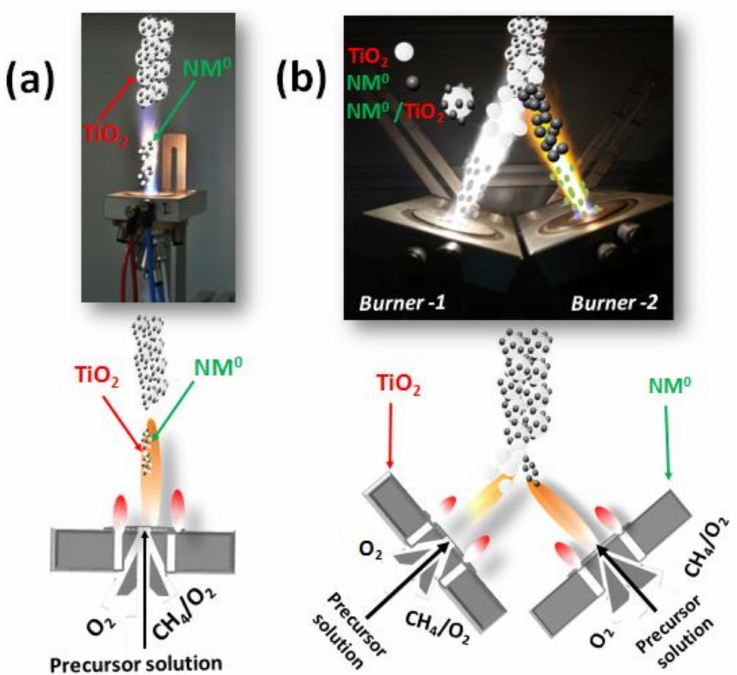
Figure 1. Our Flame Spray Pyrolysis (FSP) set-up: ( a ) One Nozzle-FSP. TiO 2 and NM 0 = Pt 0 , Pd 0 , Au 0 , Ag 0 , are formed in the same nozzle; ( b ) Double-Nozzle. Burner-1 was dedicated to the formation of the TiO 2 -nanoparticles. Burner-2 was dedicated to the formation of noble metal. The tightly interfaced NM 0 /TiO 2 is formed in